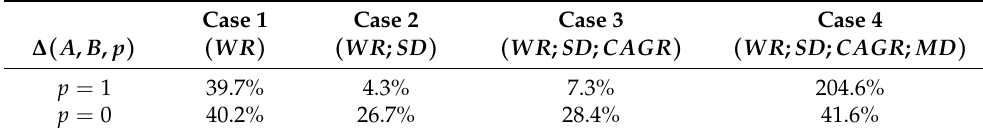
Table 3. iShares STOXX Europe 600 ETF (DE) versus EURO STOXX